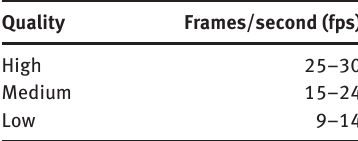
Table 3: Video Quality in Frames/Second.